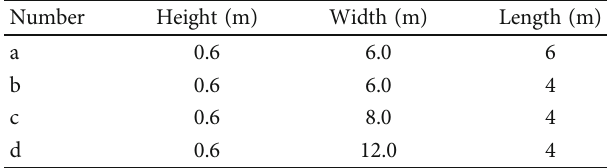
Table 2: The geometry of the freezing